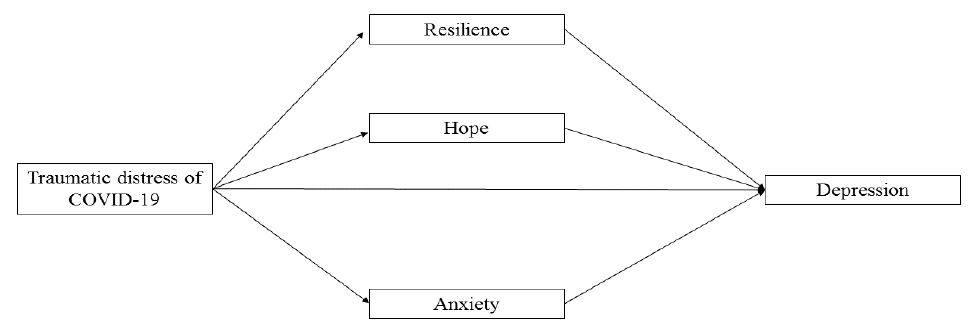
Figure 1. Representation of the hypothesized mediation model. Traumatic distress of COVID-19 is expected to influence depression levels, while resilience, hope and anxiety are expected to mediate this